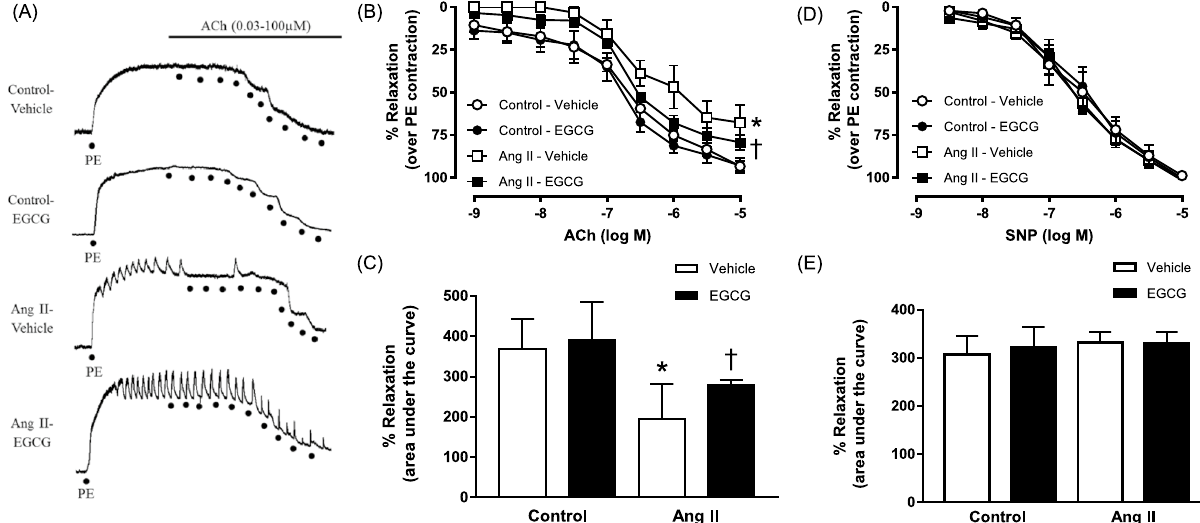
Figure 2. Relaxation to increasing concentration of acetylcholine (ACh) and sodium nitroprusside (SNP) in aortic rings of control and angiotensin (Ang) II-infused hypertensive C57BL/6J mice. ( A ) Representative traces of acetylcholine-induced relaxation in phenylephrine (PE)-contracted aortic rings of all experimental groups. ( B ) Relaxation curves and ( C ) area under the curve for percentage of relaxation in aortic rings of control and angiotensin II-infused hypertensive mice, with and without in vivo treatment with epigallocatechin gallate (EGCG) to ACh. ( D ) Relaxation curves and ( E ) area under the curve to SNP of all experimental groups. Data are expressed as means ± SEM (n = 5–6). *p ≤ 0.05 compared to control—vehicle; † p ≤ 0.05 compared to Ang II— vehicle.